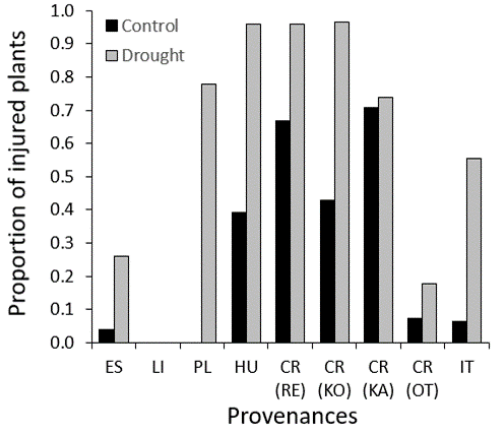
Figure 4. Proportions of frost-injured plants by provenance and treatment . Provanance abbreviations: